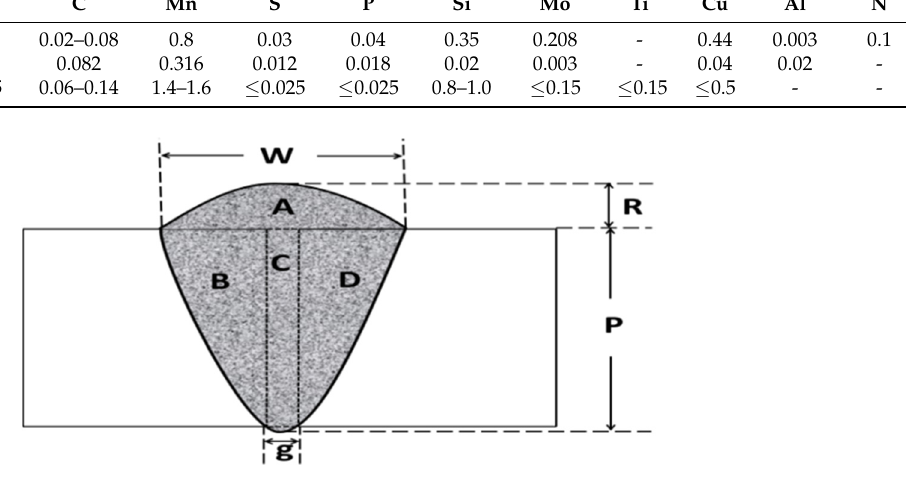
Figure 3. Bead geometry, W—width; R—reinforcement; P—penetration; g—root gap. Dilution is the measure of the ratio of the area of base metal melted (B+D) to the total weld bead area (A + B + C + D) as represented in Figure 3. Area B and D are considered as right-angled triangles and the reinforcement area is approximated by W*R/2. The formula for calculating dilution percentage (D%) is